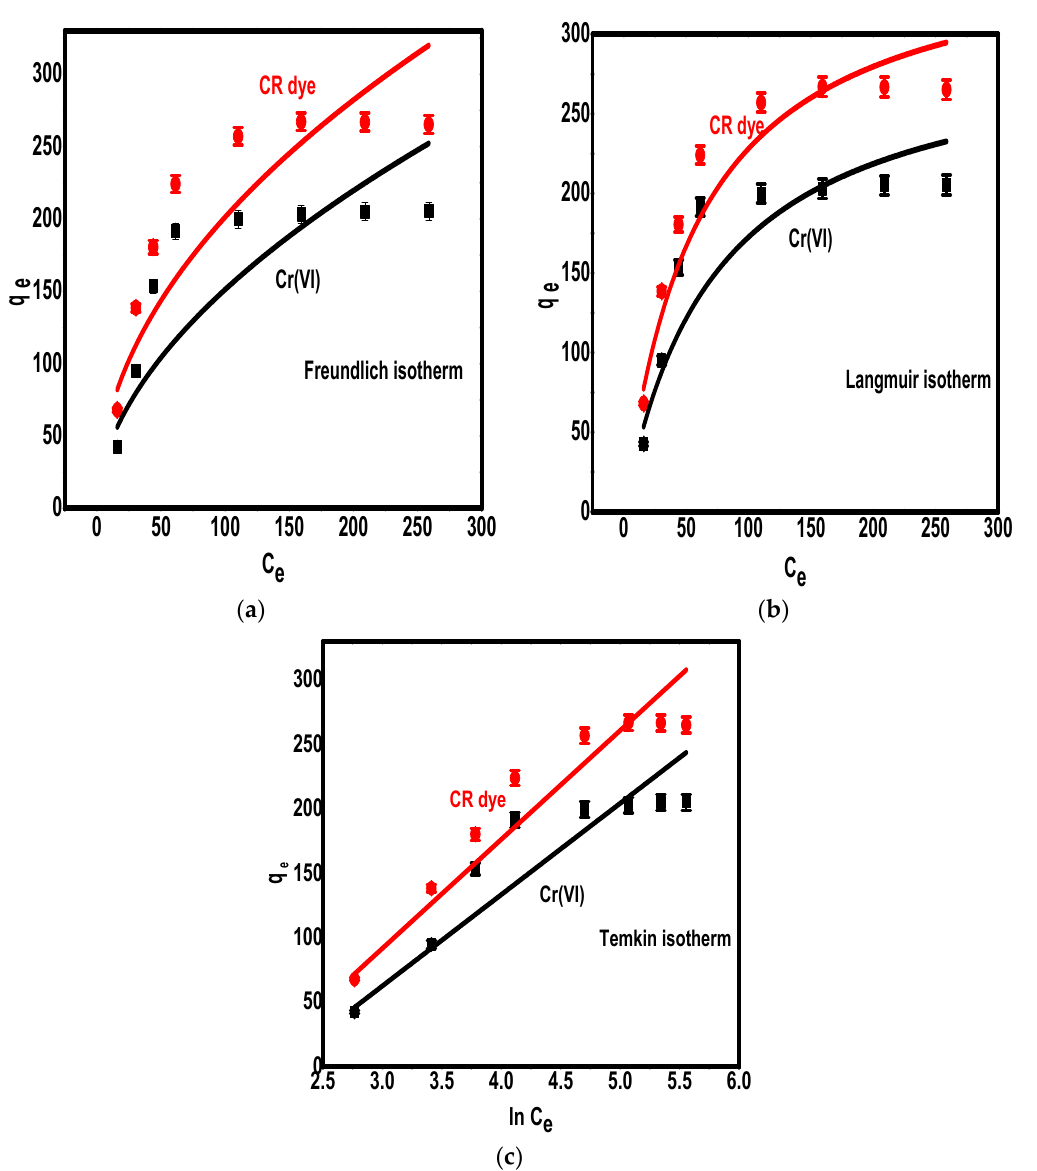
Figure 4. Plotting of Freundlich isotherm ( a ), Langmuir isotherm ( b ), and Temkin isotherm ( c ) for the removal of Congo red dye and Cr(VI) metal ions over the PPy/Fe 3 O 4 /SiO 2 nanocomposite.